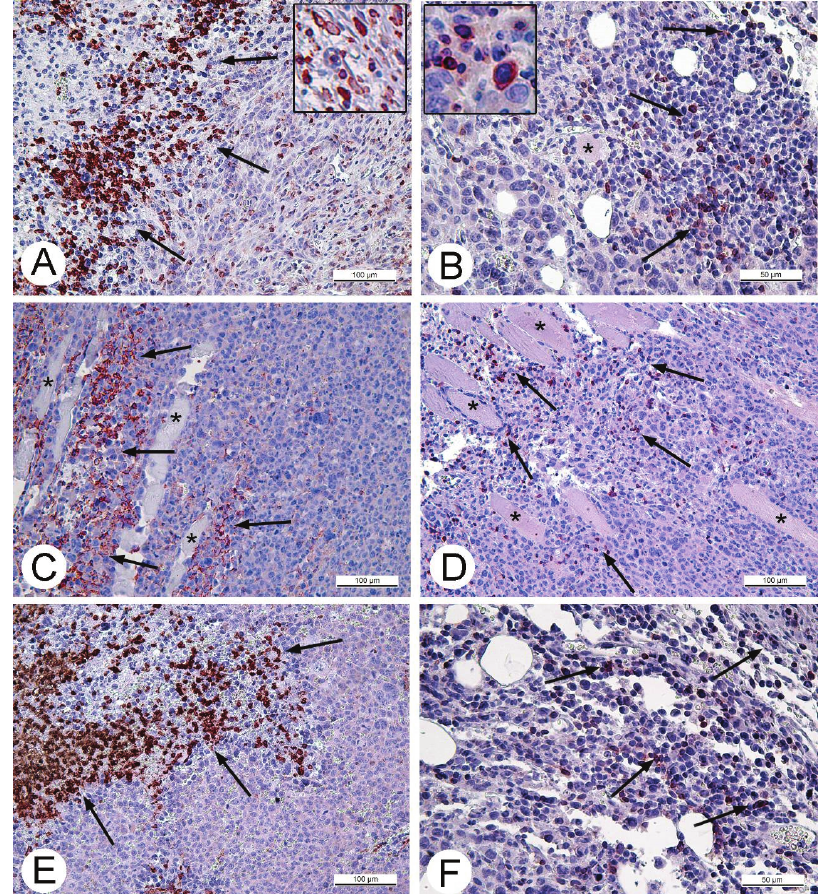
Figure 5. Immunohistochemical detection of monocytes and granulocytes (CD11b antibodies) and T-lymphocytes (CD3 antibodies) in paraffin sections of Ehrlich carcinoma. Upper arrow shows reaction in sections of saline-treated tumors ( A ) CD11b-positive cells; and ( B ) CD3-positive cells, both 14 days after injection. Inserts show positively stained cells at high magnification. CD11b-positive cells in the tumors injected with VACV; ( C ) 6 days and ( E ) 14 days after the injection. Rare T-lymphocytes are seen in in Ehrlich carcinoma ( D ) 6 days and ( F ) 14 days after VACV injection. Positively stained cells are shown by arrows. Asterisks show muscle fibers in Ehrlich carcinoma. Chromogen AEC, counterstained with